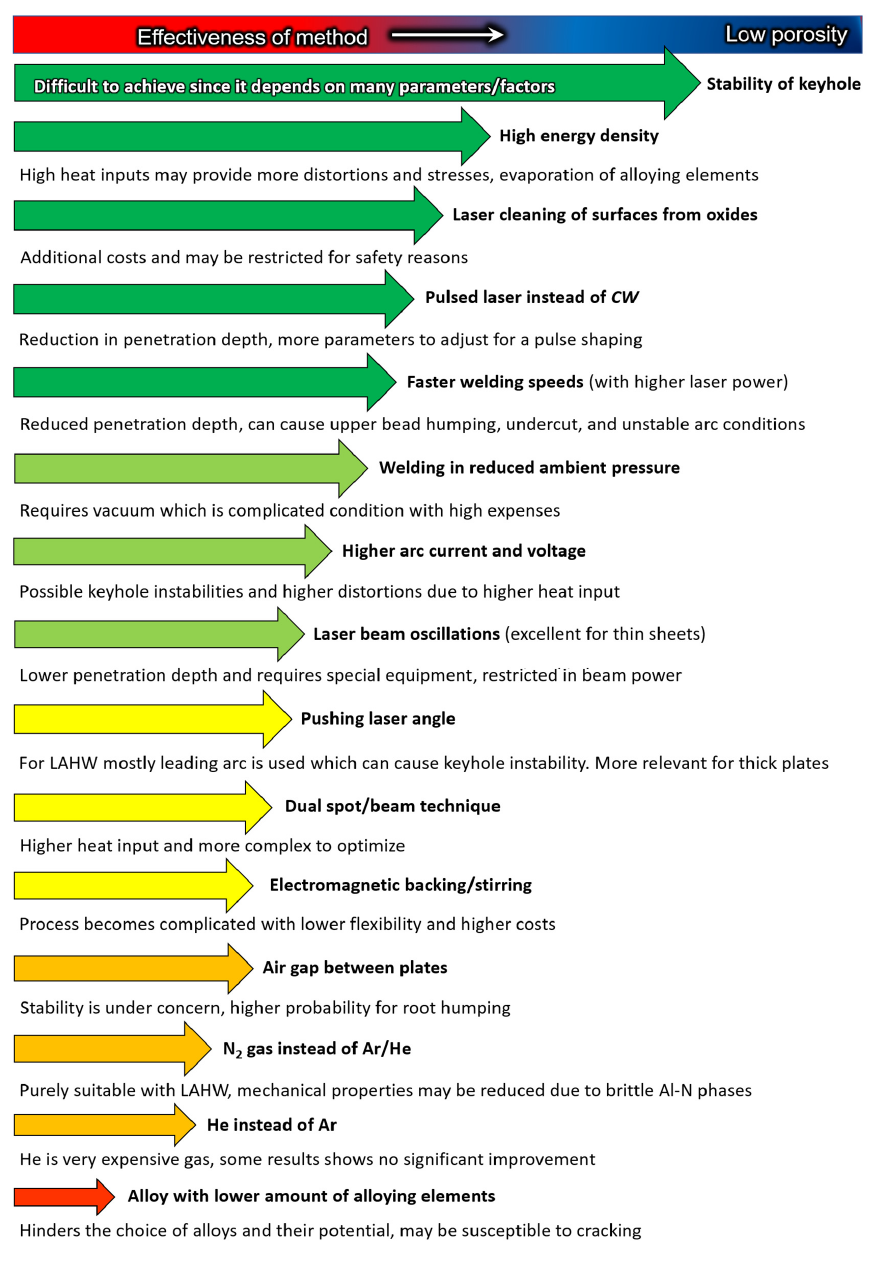
Figure 20. Porosity mitigation mechanisms in LBW/LAHW. Note, ranking is based on effectiveness, costs, and practical use in industry. Below the arrows, the reasons of low overall effectiveness and disadvantages are presented. 9. Bead formation, Undercut, and Spattering LBW of aluminium alloys frequently has an uneven weld bead appearance due to an unstable melt pool [247]. Main external weld seam defects are undercut and underfill (top and root), spattering, and humping at the top and bottom surfaces (see Figure 21). The generation of undercuts, spattering, and root humping is attributed to low surface tension